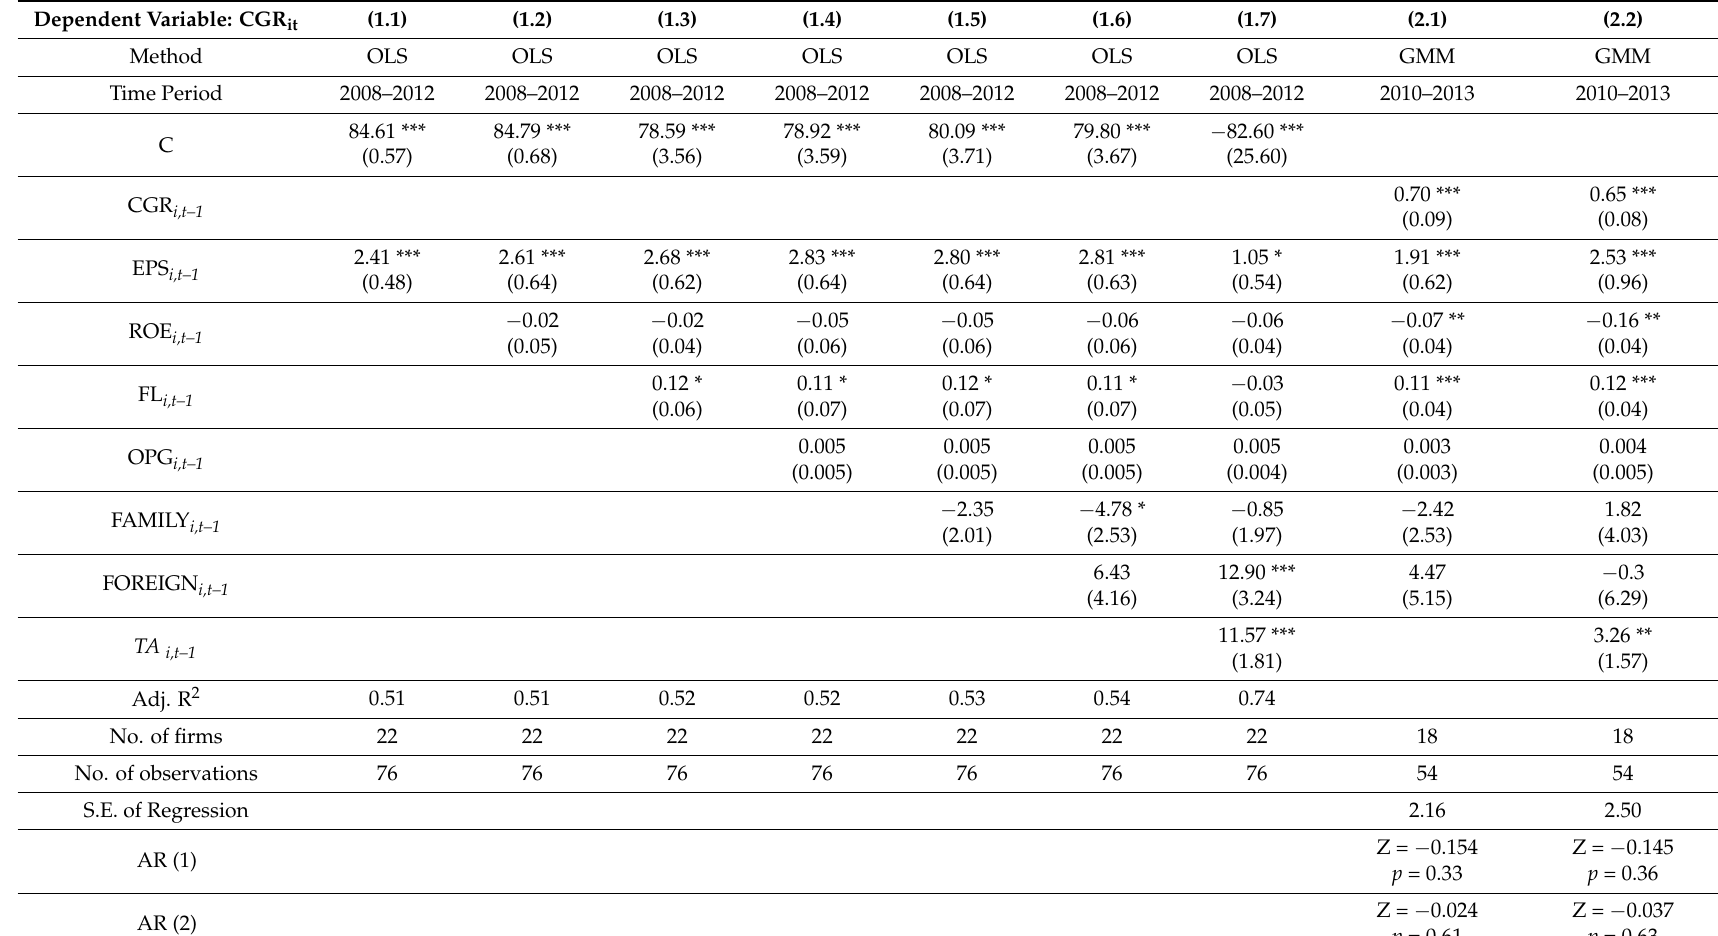
Table 5. Estimation